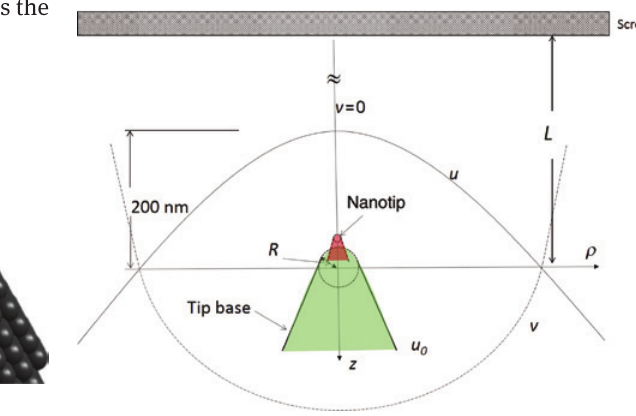
Figure 6: Illustration of the use of ring counting method on the same ball model shown in Figure 4D. Figure 7: A schematic of the FES model of a